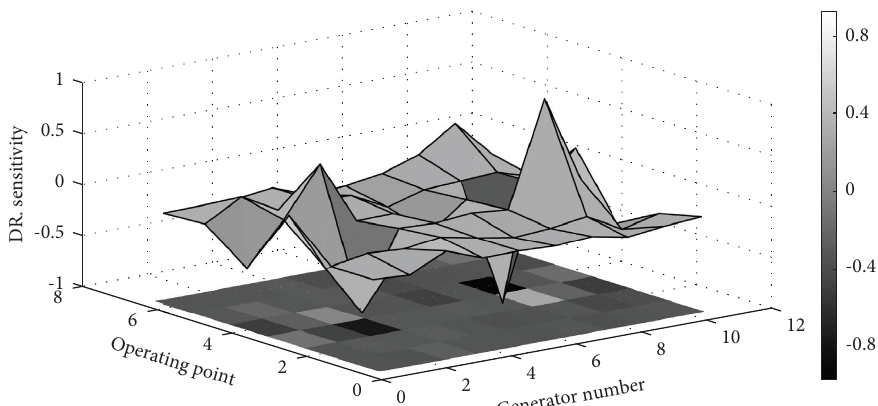
Figure 3: Damping ratio sensitivity at diferent operating points for IEEE 39-bus